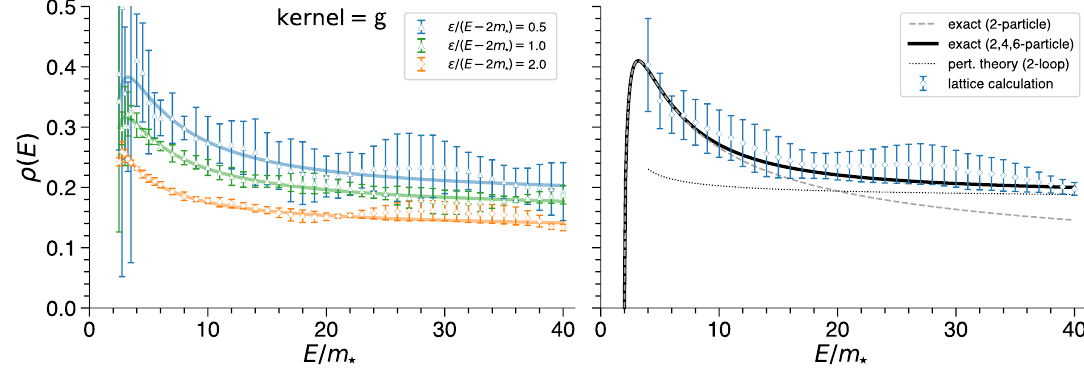
Figure 9 . Left : numerical results for ρ (cid:15) ( E ) for the Gaussian kernel and the spectral density including up to six-particle contributions (solid lines) smeared with the same kernel at different values of (cid:15)/ ( E − 2 m ? ) . Right : results for ρ ( E ) after extrapolation (cid:15) → 0 , together with the exact two-particle contribution (light dashed line), the two-, four-, and six-particle contributions (dark solid line), and the 2-loop perturbative result (dark dotted line). Statistical and systematic errors due to the finite volume, continuum limit, and (cid:15) → 0 extrapolation are combined in quadrature as described in the